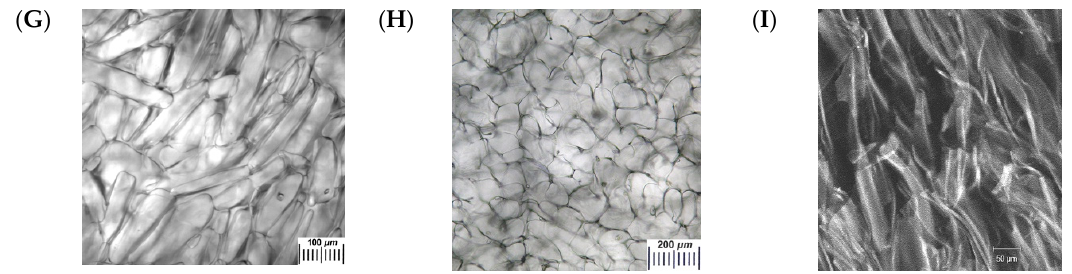
Figure 1. Micrographs demonstrating the macroporous morphology of various polymeric cryogels. and cryostructurates: ( A ) PVA-based cryogel ( 51a in Table 1) formed in a frozen ( − 20 °C/12 h) aqueous system (10- μ m-thick thin section stained with Congo red; transmission optical microscope). ( B ) Agarose-based cryogel ( 53a in Table 1) formed in a frozen ( − 30 °C/1 h followed by − 10 °C/23 h) aqueous system (10- μ m- thick thin section stained with Cresyl violet; transmission optical microscope). ( C ) Polystyrene-based cryostructurate formed in the crystallized (+25 °C/4 h) naphthalene followed by its extraction with methanol (1-mm-thick layer; transmission optical microscope). ( D ) Butadiene- co -styrene-latex-based cryostructurate ( 65 in Table 1) formed in a frozen ( − 20 °C/12 h) aqueous system (1-mm-thick layer; transmission optical microscope). ( E ) Poly(NIPAAM-co-DMAPA)-based cryogel ( 59 in Table 1) formed in